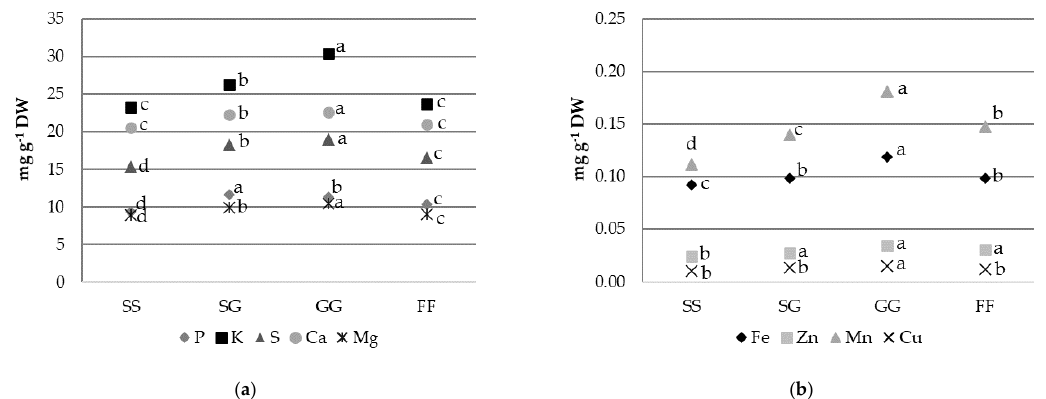
Figure 3. Mineral element contents in tomato leaves in the “growth” stage, illuminated with different light spectrums during growth stages: ( a ) macroelements; ( b ) microelements. Different letters indicate statistically significant differences between means according to Fisher’s test at the confidence level p = 0.05.